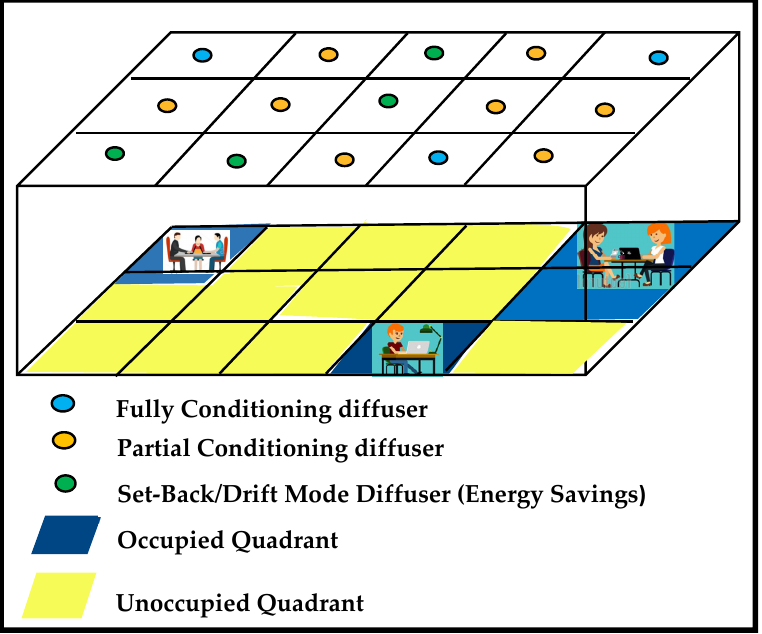
Figure 1. Smart HVAC efficiency diagram with air conditioning only in blue quadrants [1] .